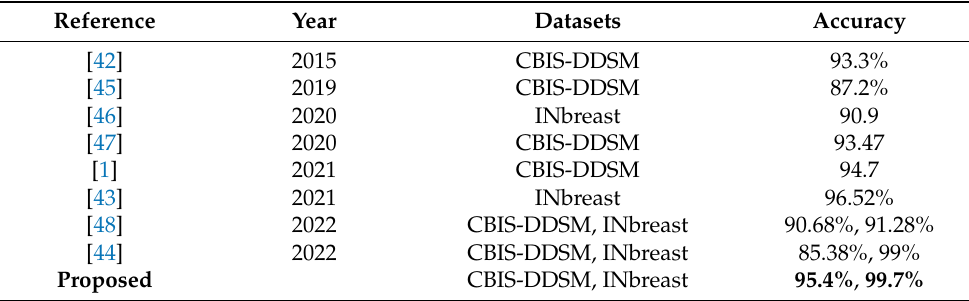
Table 10. Comparison of the proposed framework with recent state-of-the-art techniques.